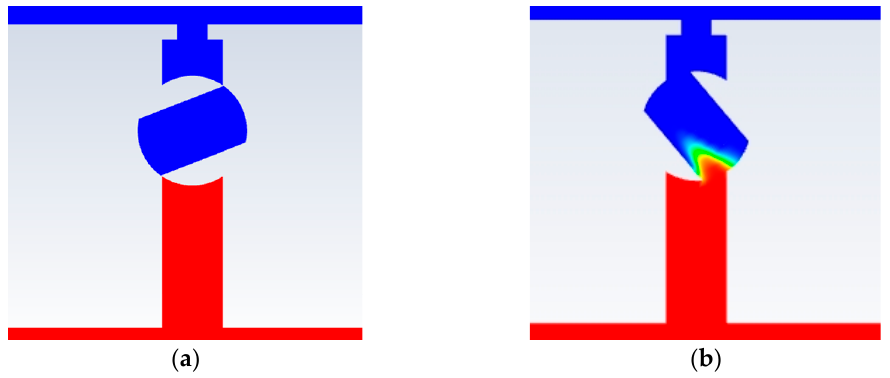
Figure 4. Distribution diagram of phase fraction: ( a ) before valve opening; ( b ) after the valve is opened.